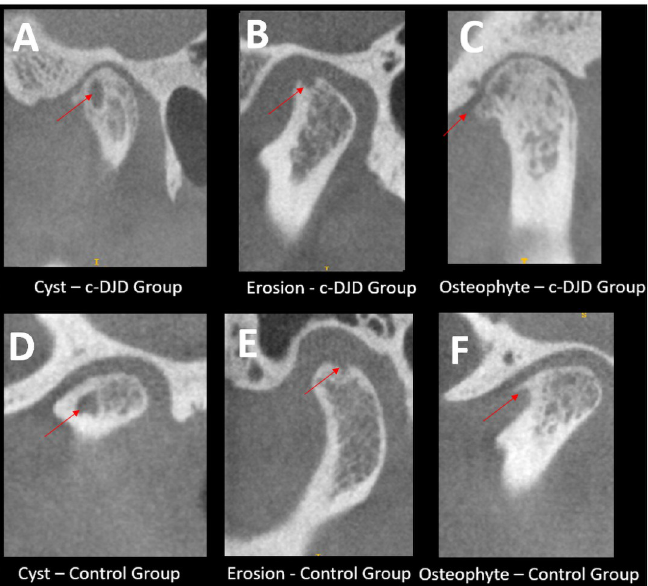
Fig 4. Radiographic findings determinants for DJD. Each image shows the sagittal slices of the TMJs and hr-CBCT with isotropic voxel size of 0.08 mm with the arrows are pointing to the finding. A-C: Represents the DJD group and D–F the asymptomatic control